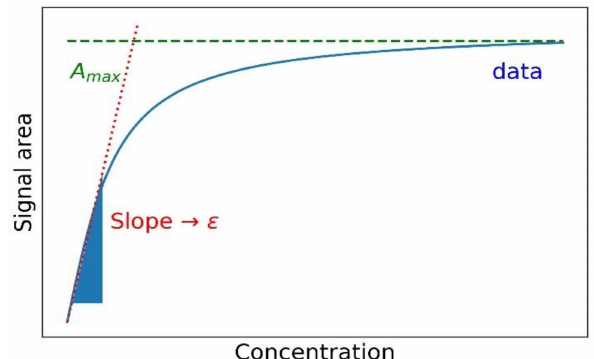
Figure 2. Determination of extinction coe ffi cient. (The green dotted line represents the maximum detected signal area, the red dotted line is the linear slope of the data curve).